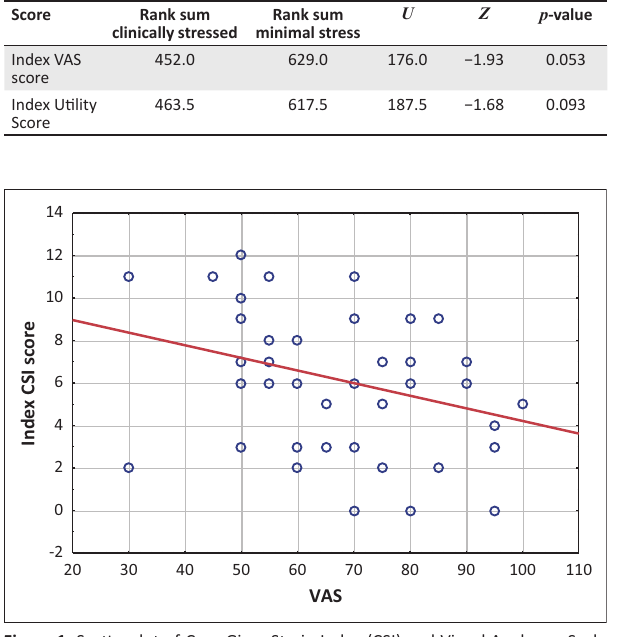
Figure 1: Scatterplot of Care-Giver Strain Index (CSI) and Visual Analogue Scale (VAS)